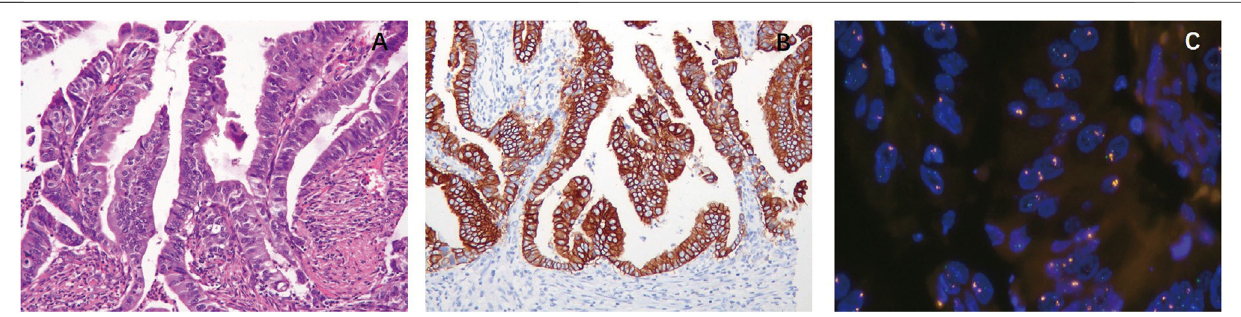
Frontiers in Genetics |